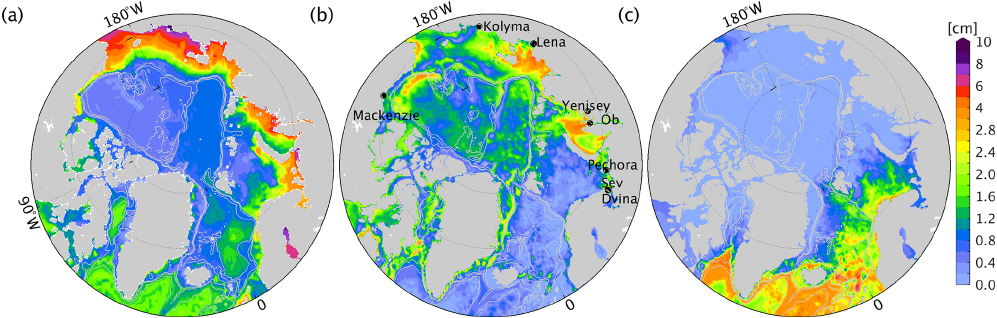
Figure 7. The rms variability of (a) mass, (b) halosteric, and (c) thermosteric components during the seasonal periods.